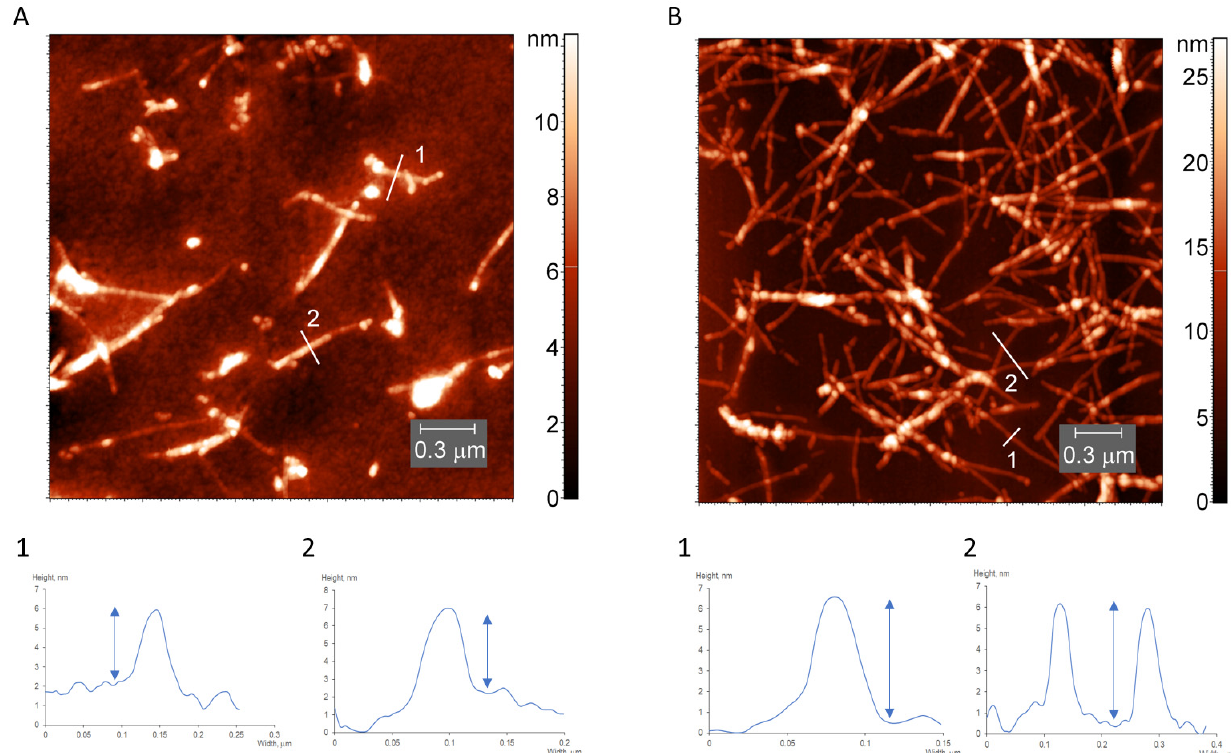
Figure 4. AFM images and height profiles of the light ( A ) and heavy ( B ) fractions of desalted lyso- lysozyme zyme fibrils.